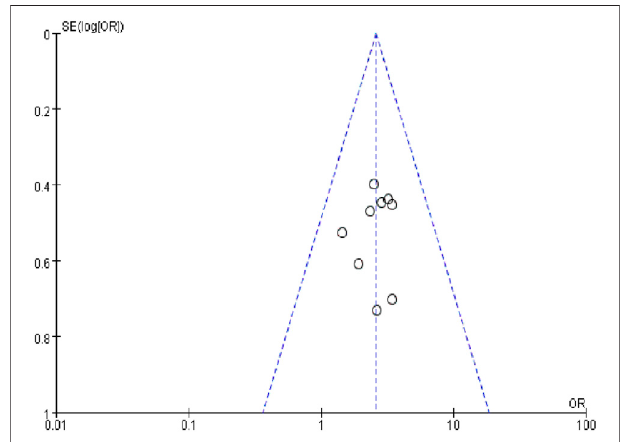
FIGURE 9 | Funnel plot of publication